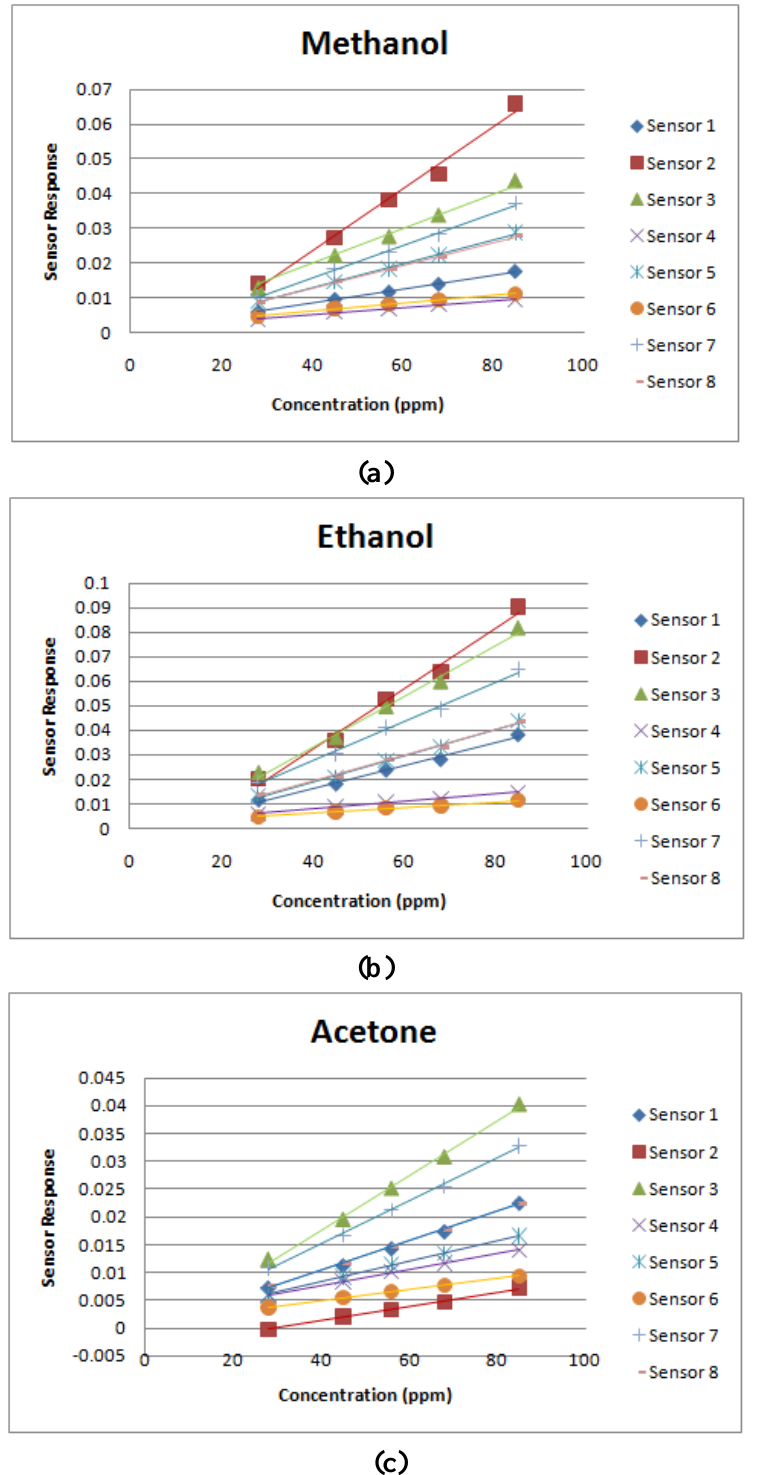
Figure 4. The response of each sensor over three vaporized solvents: (a) methanol, (b) ethanol and (c) acetone, under different